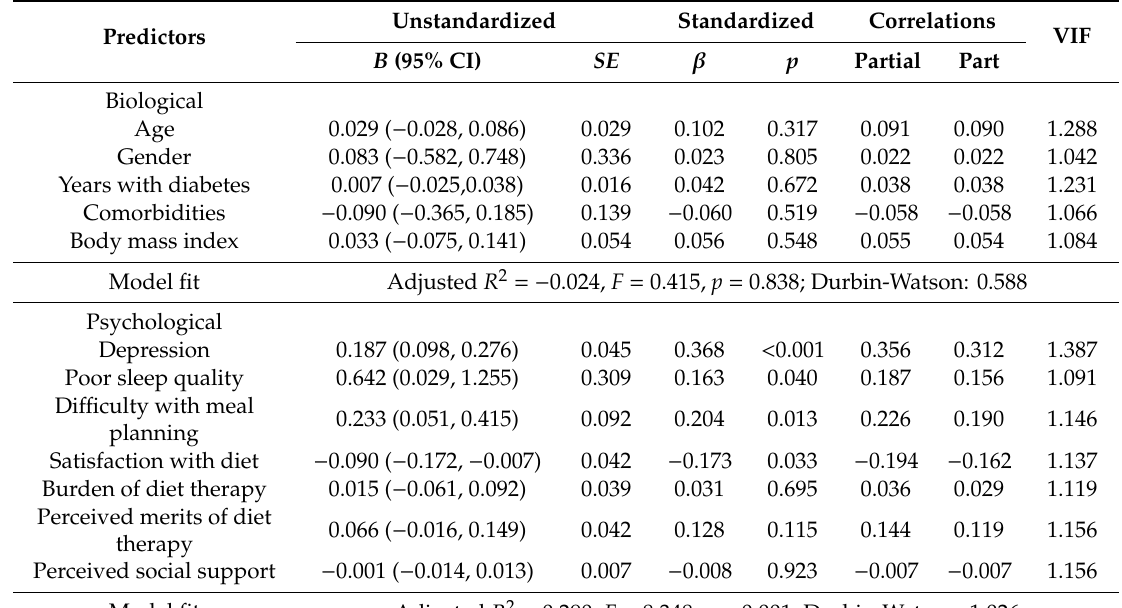
Table 2. Multiple regression analysis for predicting fatigue severity on each domain of the dynamic biopsychosocial (DBPS)